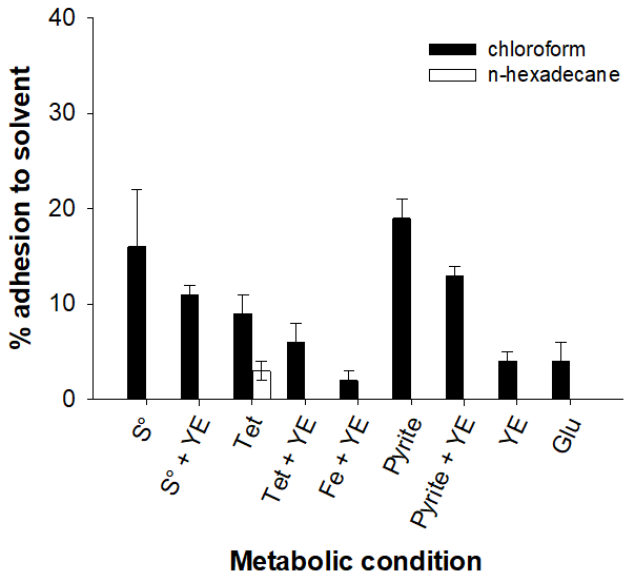
Figure 2. Adhesion percentages of A. copahuensis to chloroform and n -hexadecane, cultured in nine different growth conditions: elemental sulfur (S°), elemental sulfur and yeast extract (S° + YE), potassium tetrathionate (Tet), potassium tetrathionate and yeast extract (Tet + YE), ferrous iron and yeast extract (Fe + YE), pyrite, pyrite and yeast extract (Pyrite + YE), yeast extract (YE), and glucose (Glu). Error bars show standard deviation from three independent experiments ( n = 3).